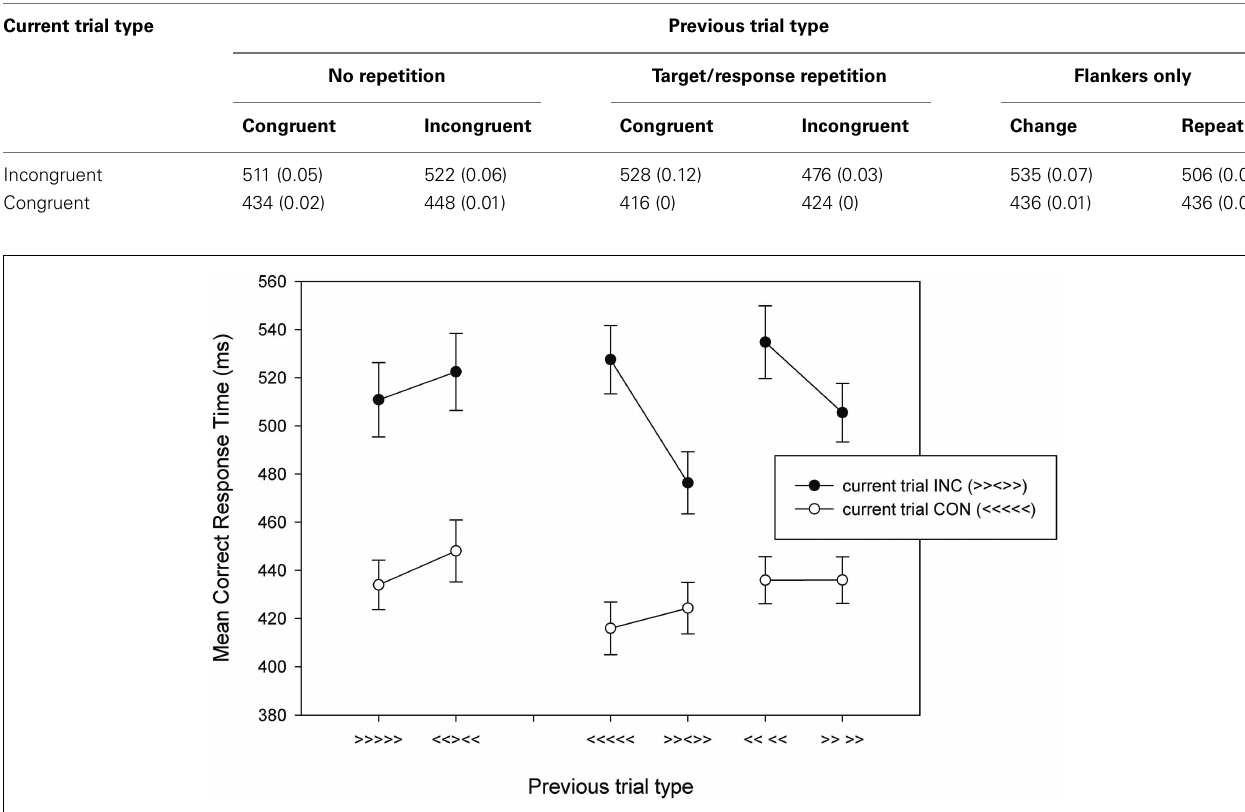
FIGURE 5 | Mean correct RTs as a function of current trial type and previous trial type for Experiment 2. Examples of previous and current trials are presented in brackets. INC, incongruent; CON, congruent.